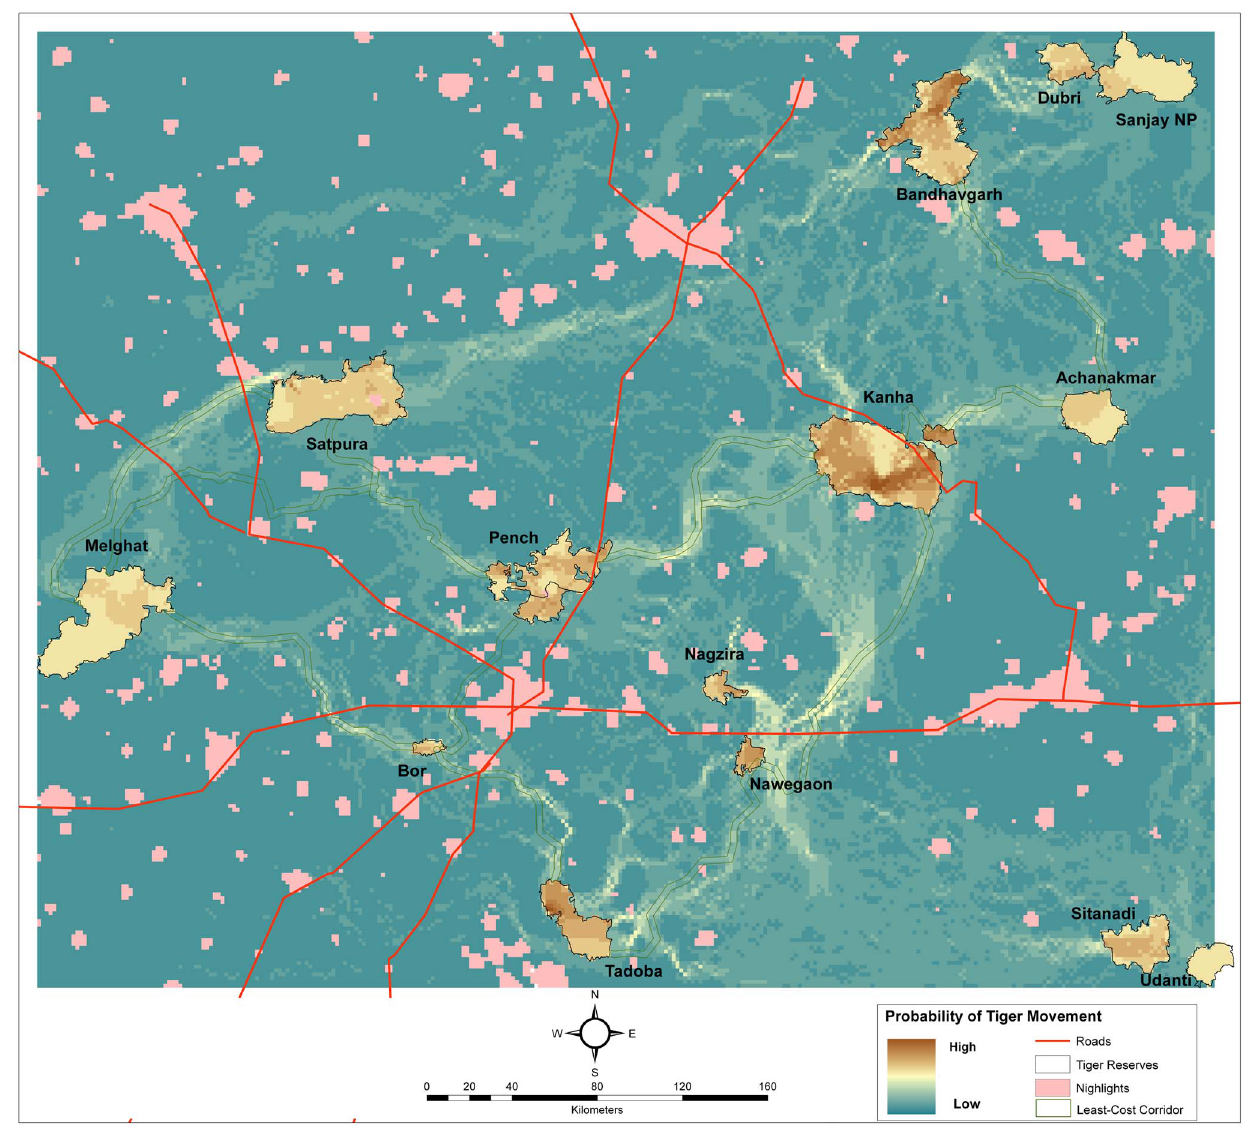
Figure 4. CIRCUITSCAPE model of cumulative current flow used to estimate landscape permeability to tiger movement. Tiger movement modeled as current flow within the Central Indian Landscape using tiger occupancy probability and drainage systems as conductance layers and human settlements as high resistance barriers in CIRCUITSCAPE. Light colors indicate potential habitat corridors. Note the prominent bottlenecks observed in the Kanha-Pench, Kanha-Tadoba, and Tadoba-Melghat habitat corridors.